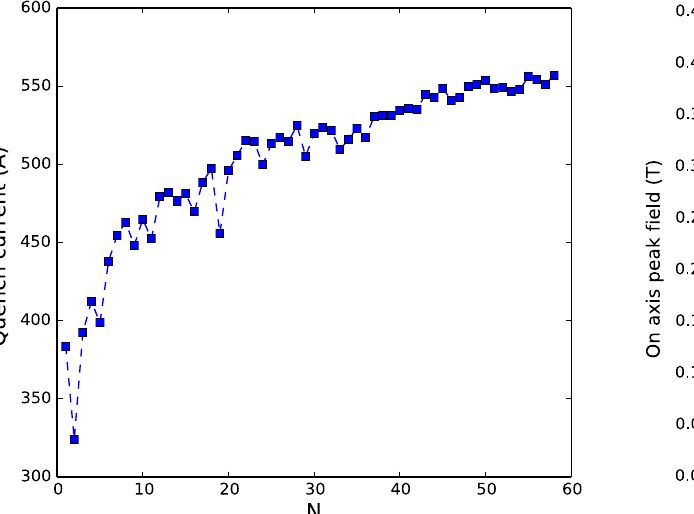
FIG. 28. Quench currents during training of the HSCU in the LHe bath cryostat.